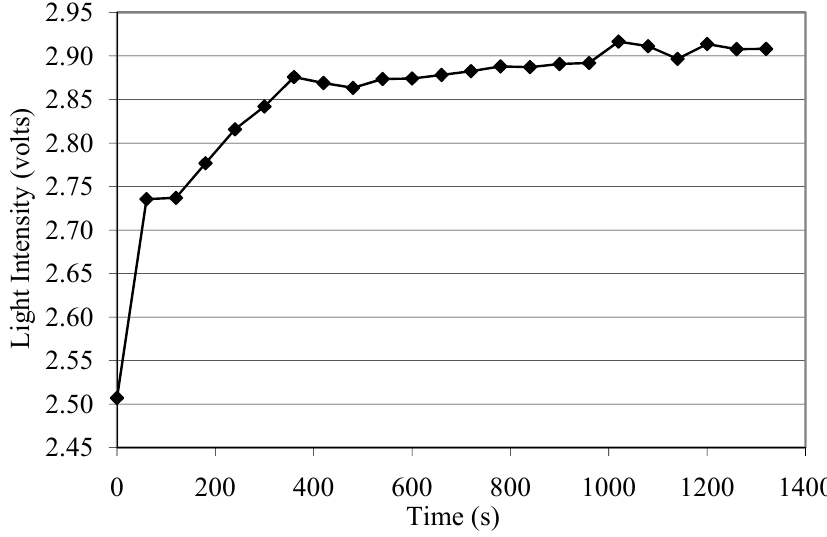
flakes every 400 2